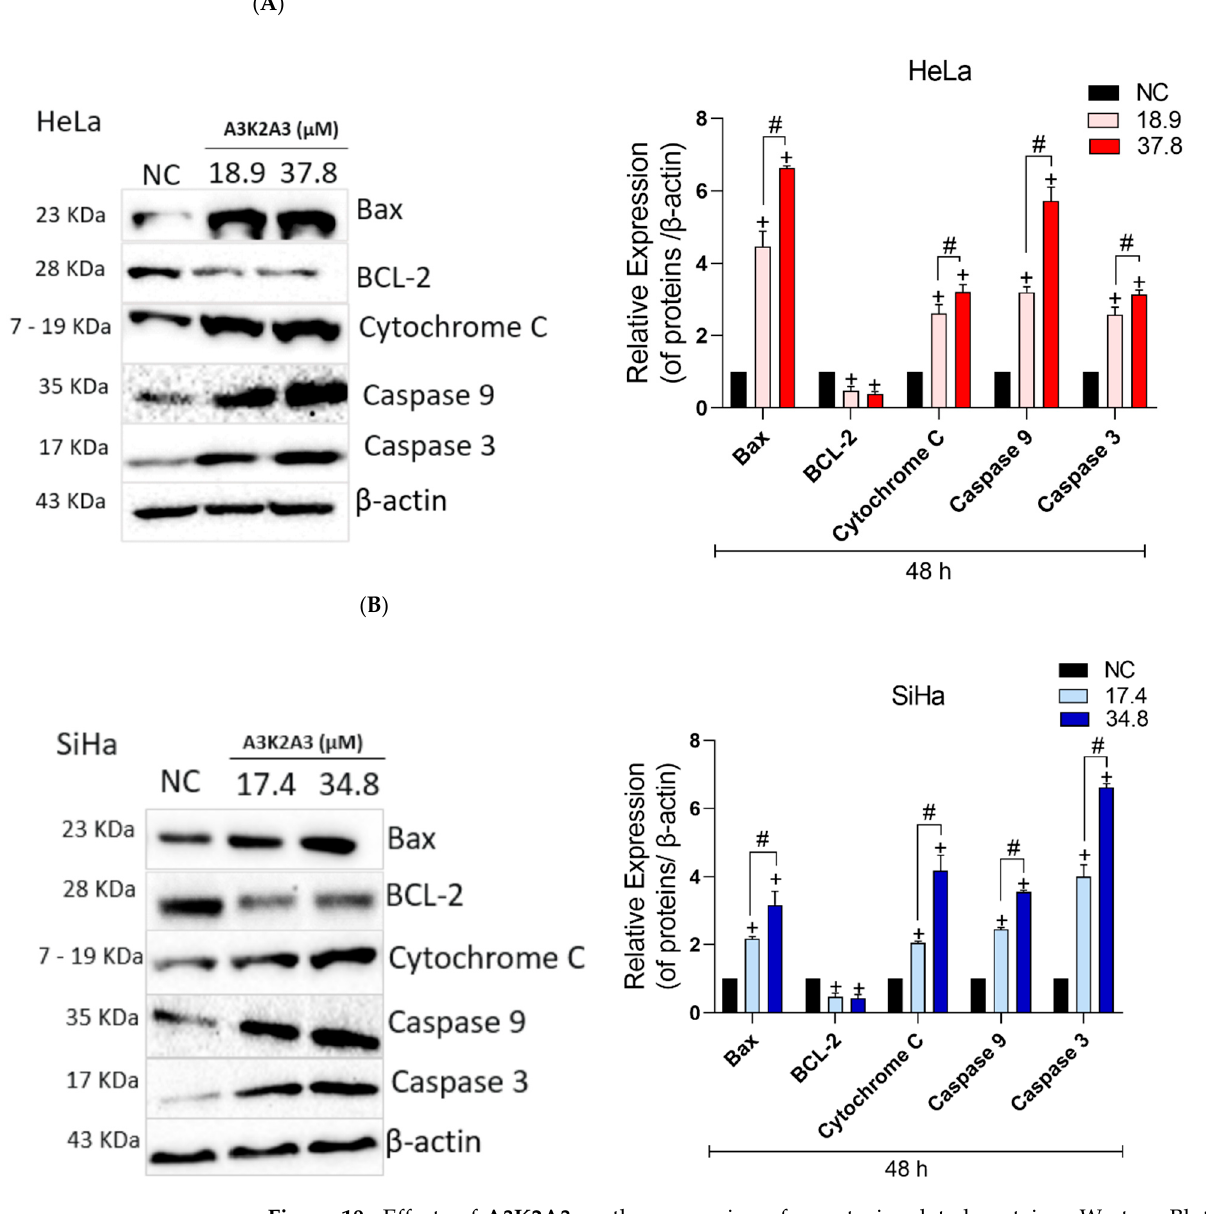
Figure 10. Effects of A3K2A3 on the expression of apoptosis-related proteins. Western Blotting ( A ) HeLa and ( B ) SiHa. Cells were treated with A3K2A3 (IC 50 or 2xIC 50 ) for 48 h. The antigen-antibody complex was detected by chemiluminescence employing ECL detection reagent and analyzed using ChemiDoc ® XRS+ Imaging System and the protein levels were determined by normalization with β -actin. Data represent the mean ± SD of three independent experiments that were performed in triplicate. ( A ) HeLa; ( B ) SiHa; + p < 0.05 compared to 48 h NC, # p < 0.05, a significant difference between A3K2A3 concentrations (one-way ANOVA followed by Tukey’s post-test).